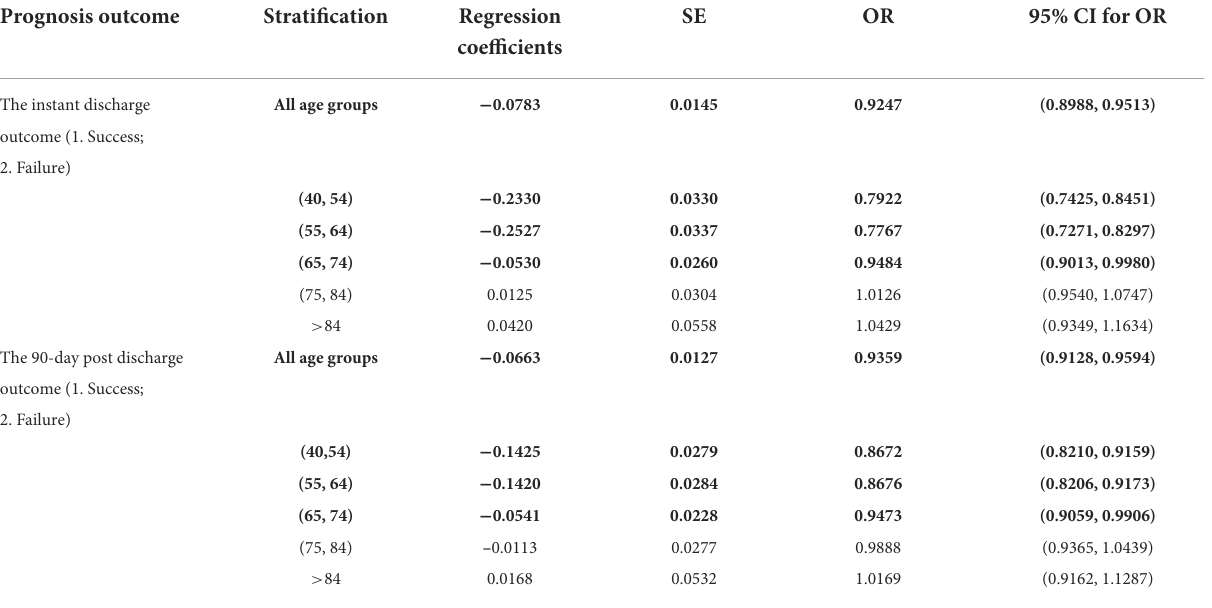
TABLE 2 The univariate estimation of sexual effect on prognosis